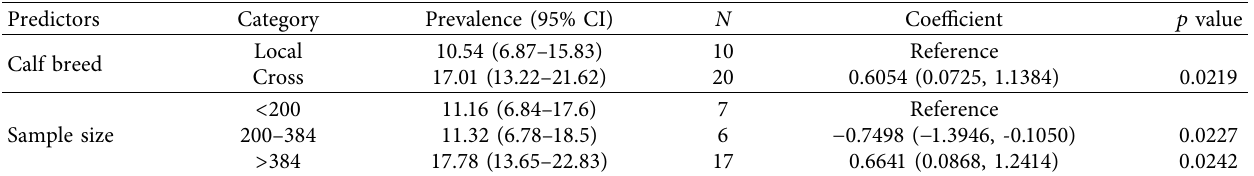
Table 4: Multivariable meta-regression model on prevalence of calves mortality in Ethiopia ( I 2 � 30.2%; N � 30